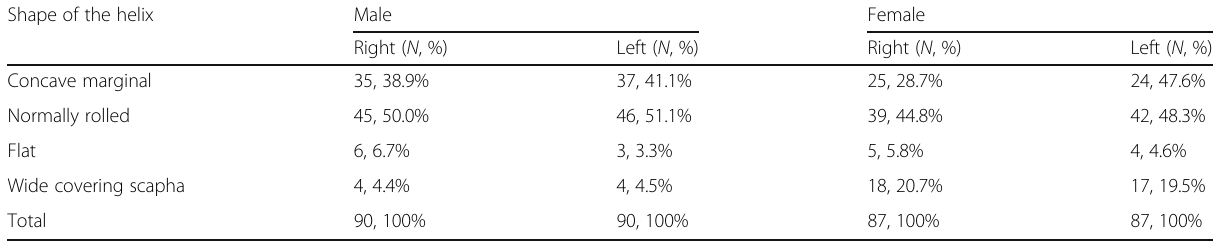
Table 2 Shape of the ear helix in males ( N = 90) and females ( N = 87) bilaterally Shape of the helix